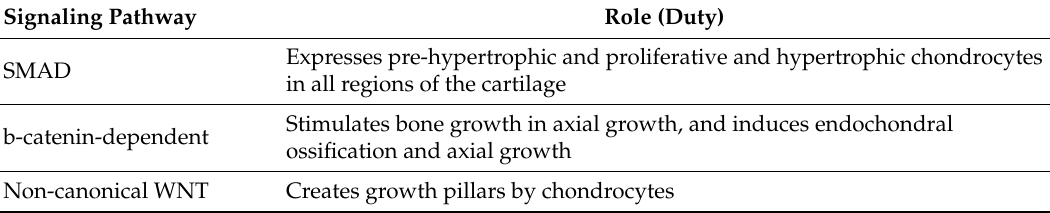
Table 2. Various cellular signaling pathways and their significant role in cartilage tissue engineering.